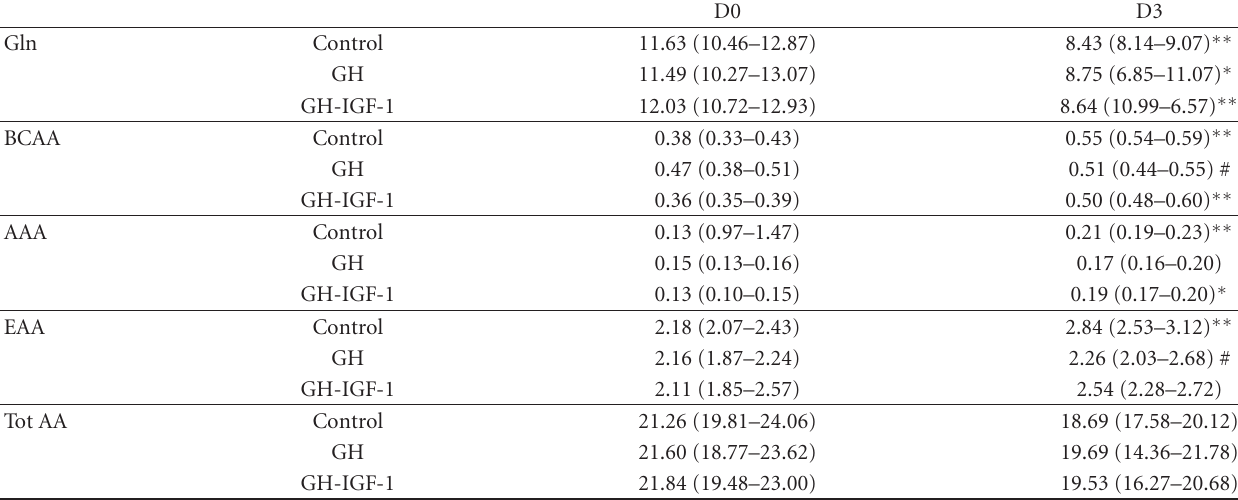
Table 5: Muscle amino acids (mmol/kg ww muscle). Glutamine (Gln), branched chain amino acids (BCAAs), aromatic amino acids (AAAs), essential amino acids (EAAs), total sum of amio acids (Tot AAs).